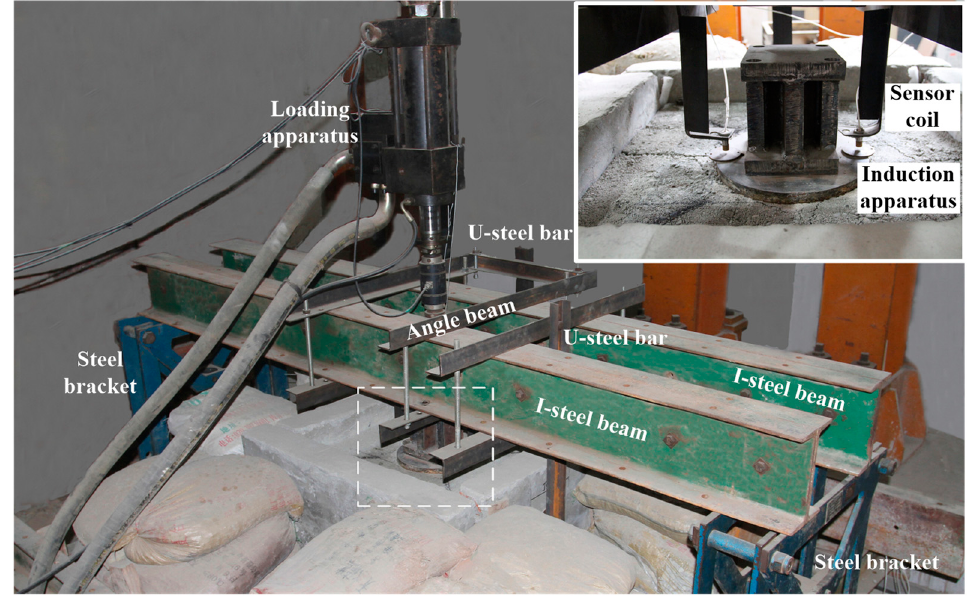
Figure 1. Model configuration. 134